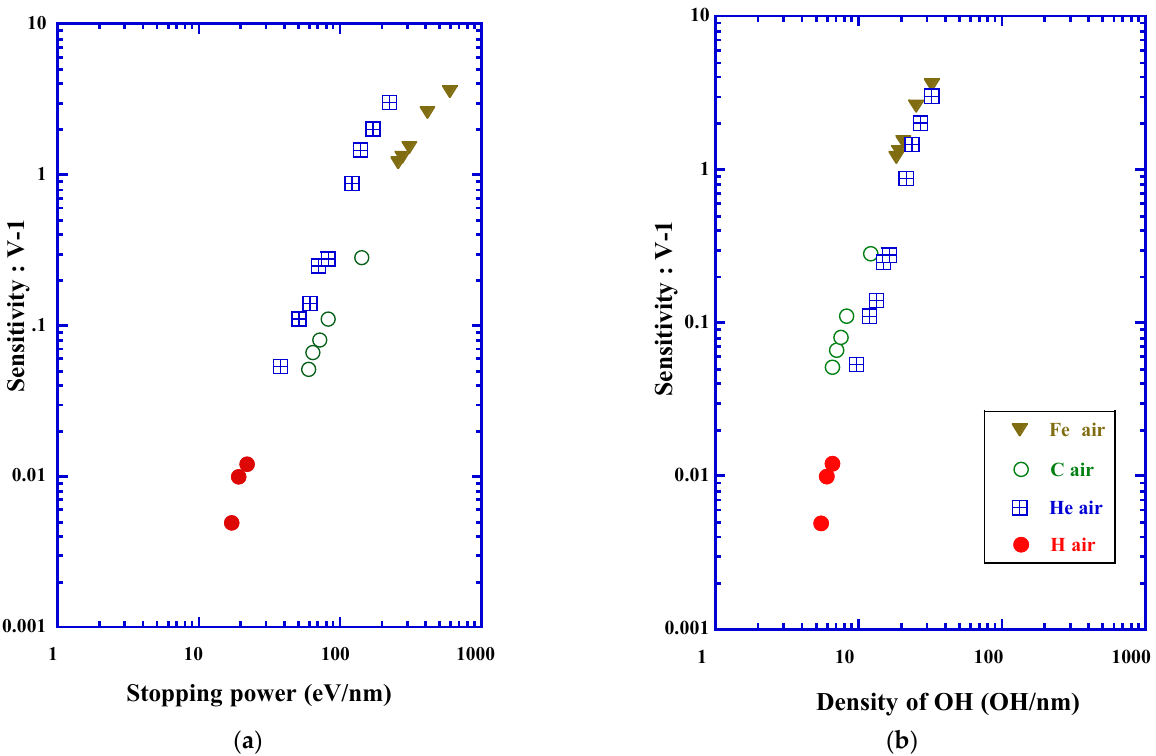
Figure 9. Track response data ( a ) as a function of the stopping power and, ( b ) as a function of the formation density of hydroxyl group.